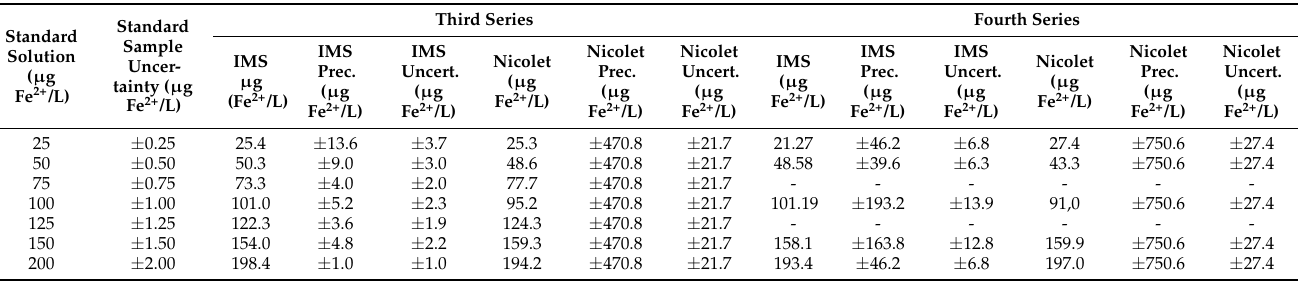
Table 3. Uncertainty analysis of standard solutions for IMS and Nicolet Evolution 300 in third and fourth series of measurements.